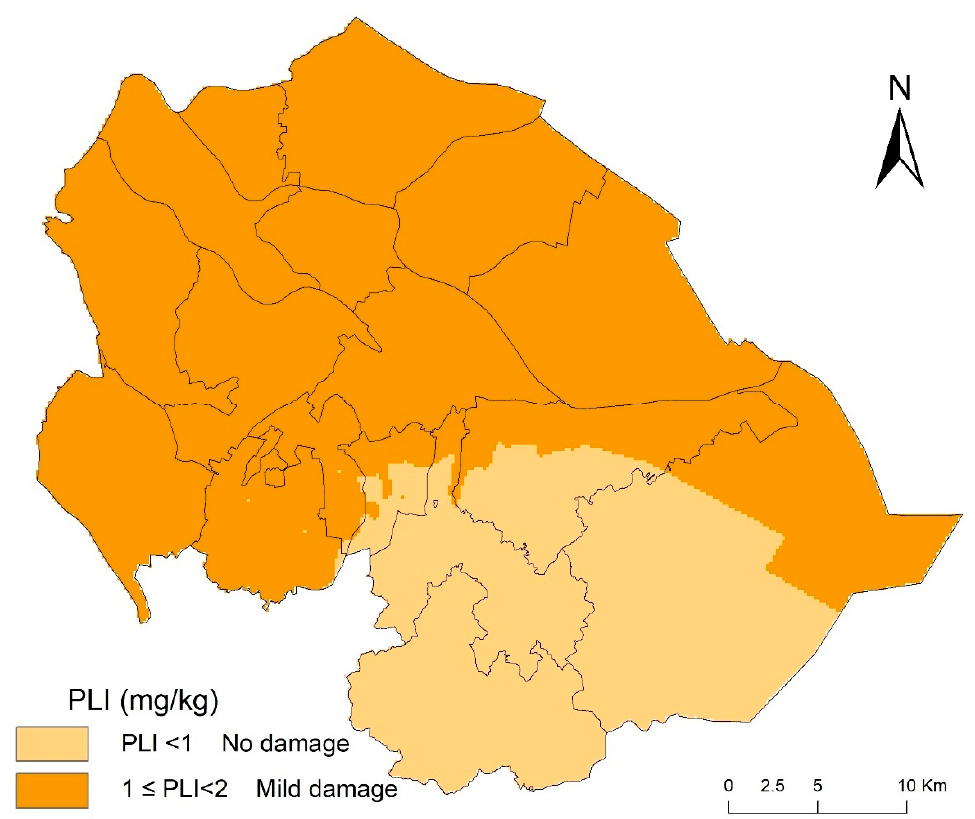
Figure 4. Spatial distributions of pollution load indexes for eight elements in Zhongshan.